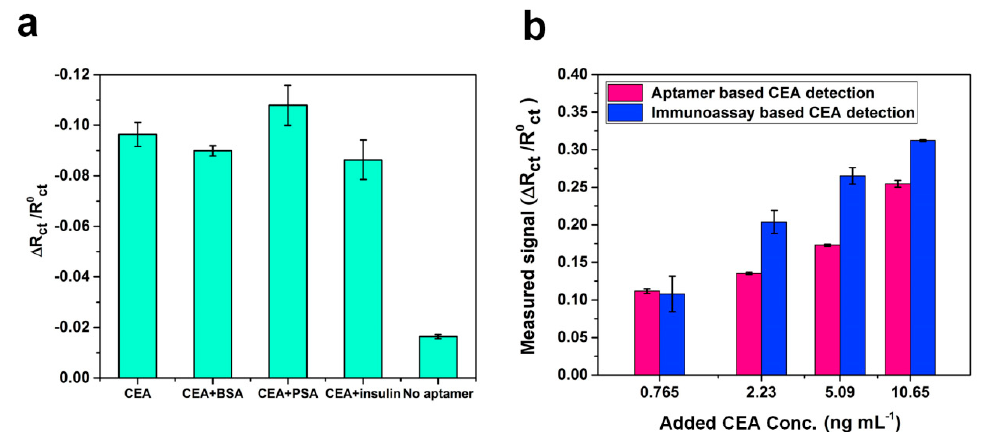
Figure 5. ( a ) Comparison of R ct response of aptasensors in the presence of other analytes including bovine serum albumin (BSA), prostate specific antigen (PSA), and insulin, as well as the working electrode without immobilizing CEA aptamers; ( b ) Comparison of R ct response of the proposed paper-based aptasensor and paper-based immunoassay sensing method. Table 1. Determination of CEA in human serum samples ( n = 3)